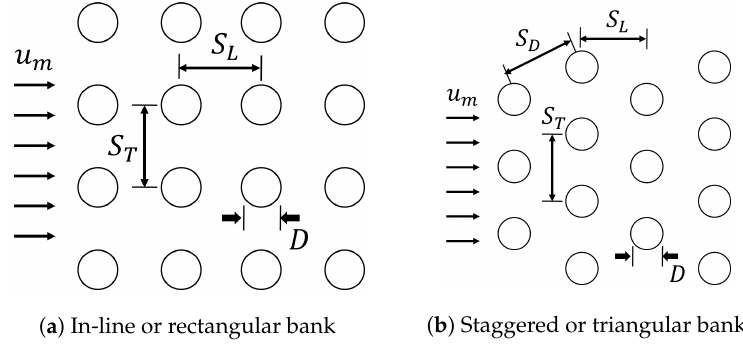
Figure 1. Tube bank geometry and main parameters.